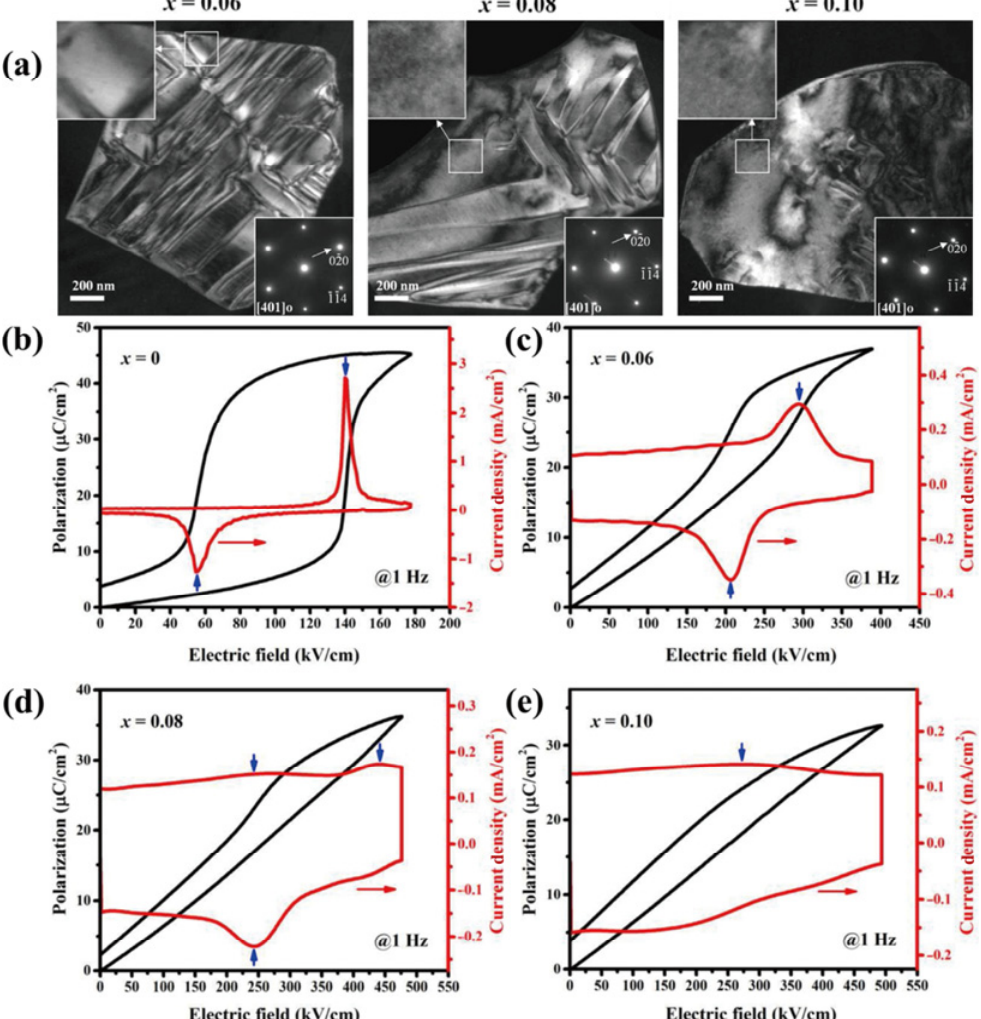
Fig. 8 (a) Dark-field TEM micrographs of ALN( x ) ceramics along the orthorhombic [401] zone axis; the insets are the corresponding selected area electron diffraction patterns and the dark-field TEM image used the reflection that the arrows mark. (b–e) P – E and current density ( I ) –E loops of ALN( x ) ceramics. Reproduced with permission from Ref. [63], © Elsevier B.V.